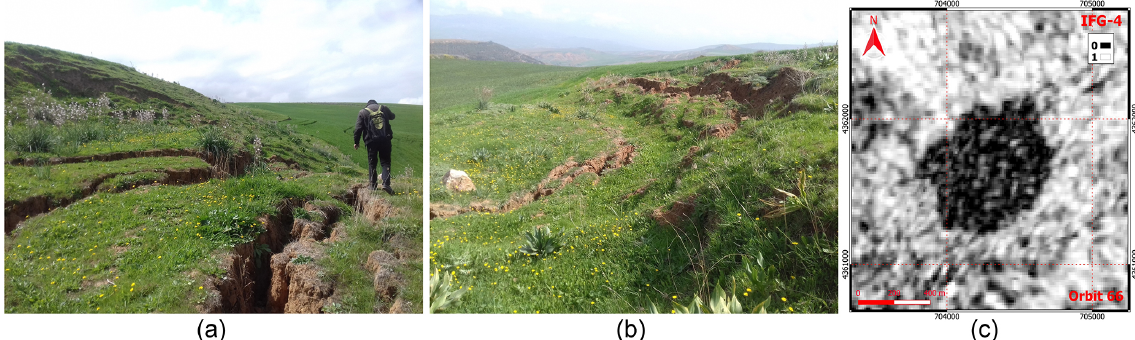
Figure 20. Landslide that occurred in the Azeba region (2km north) detected by InSAR: (a, b) visible ground cracks and (c) coherence map of Azeba zone delimited by the